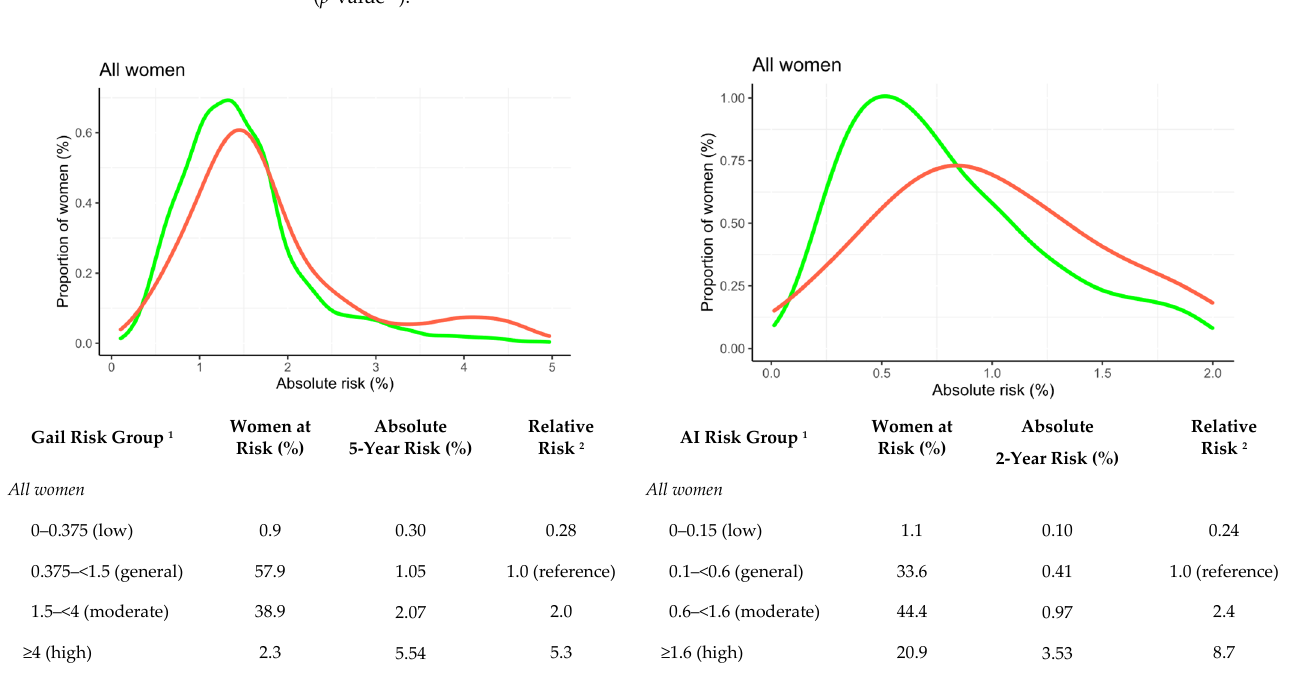
1 All women in the cohort also includes non-White and non-Black women, and women with missing information on race. AUCs adjusted for age at baseline. Confidence intervals estimated using boot- strapping. Permutation test tested for difference between AUCs in White and Black women for each model ( p -value 2 ) and between models ( p -value 3 ).